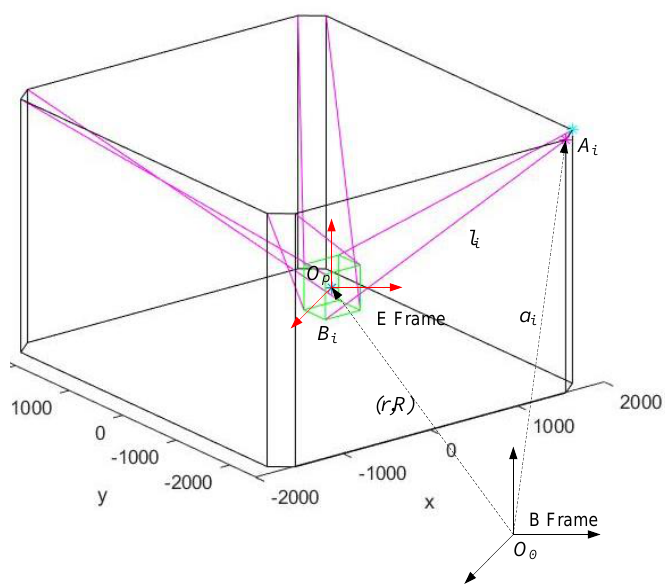
Figure 4. General kinematics of the cable robot (6 DOF; 8 cables).